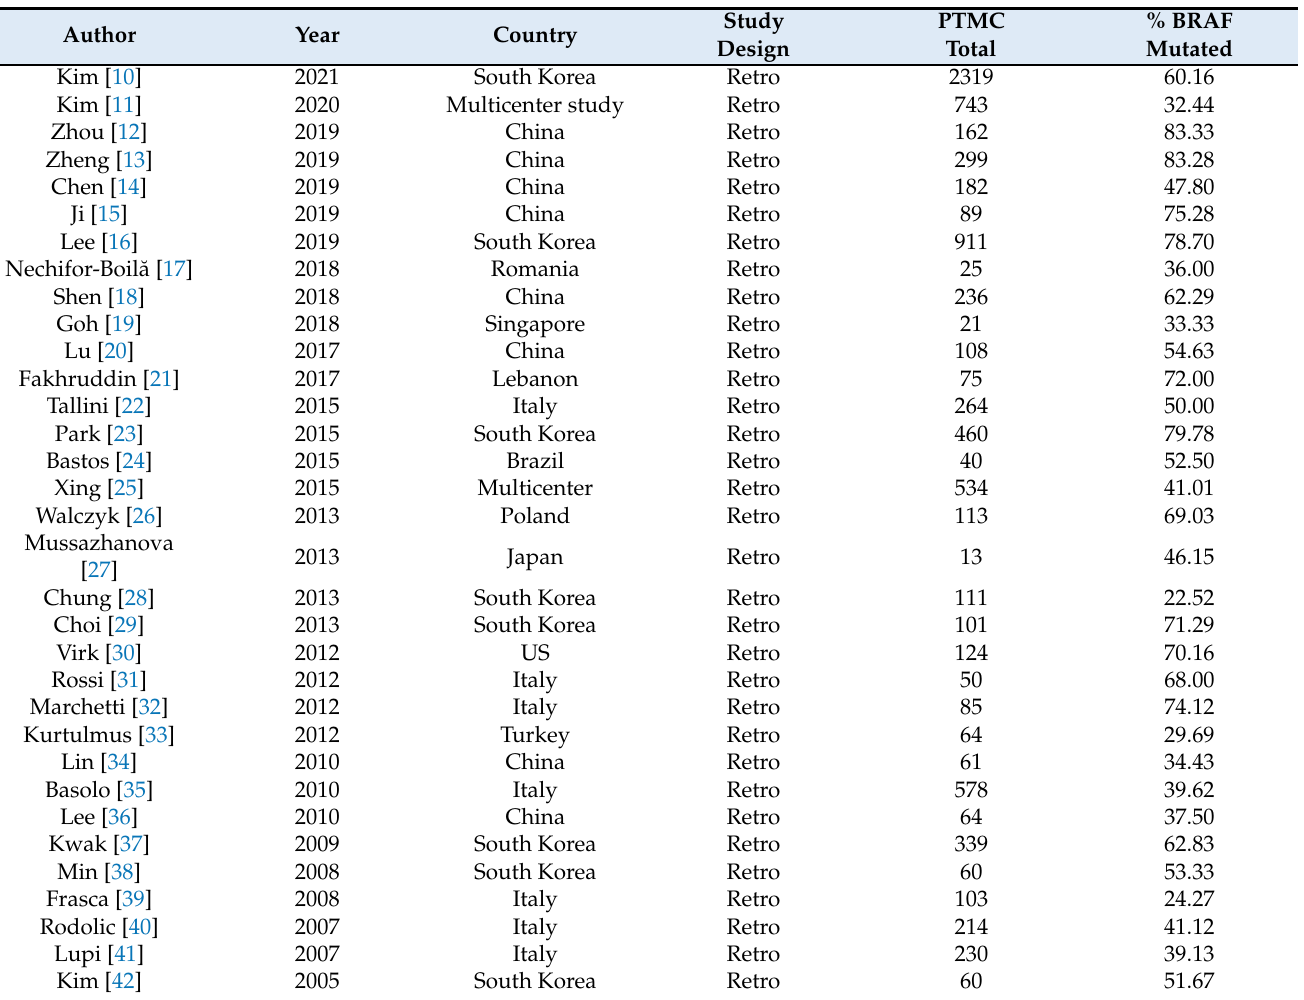
Table 1. Characteristics of the articles